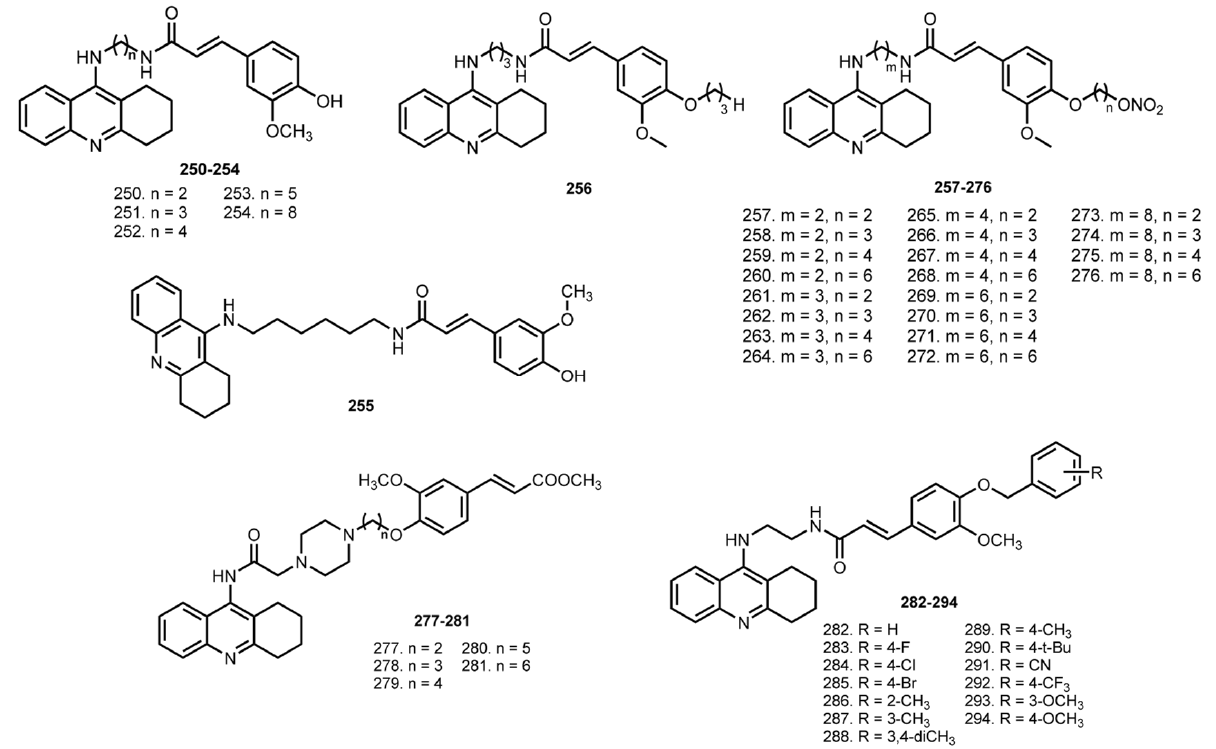
Figure 10. THA–ferulic acid hybrids 250 – 254 [59], 255 [61], THA–ferulic acid–NO ‐ donor thihybrids 257 – 276 and model hybrid 256 [30], THA–ferulic acid hybrids with piperazine linker 277 – 281 [62],